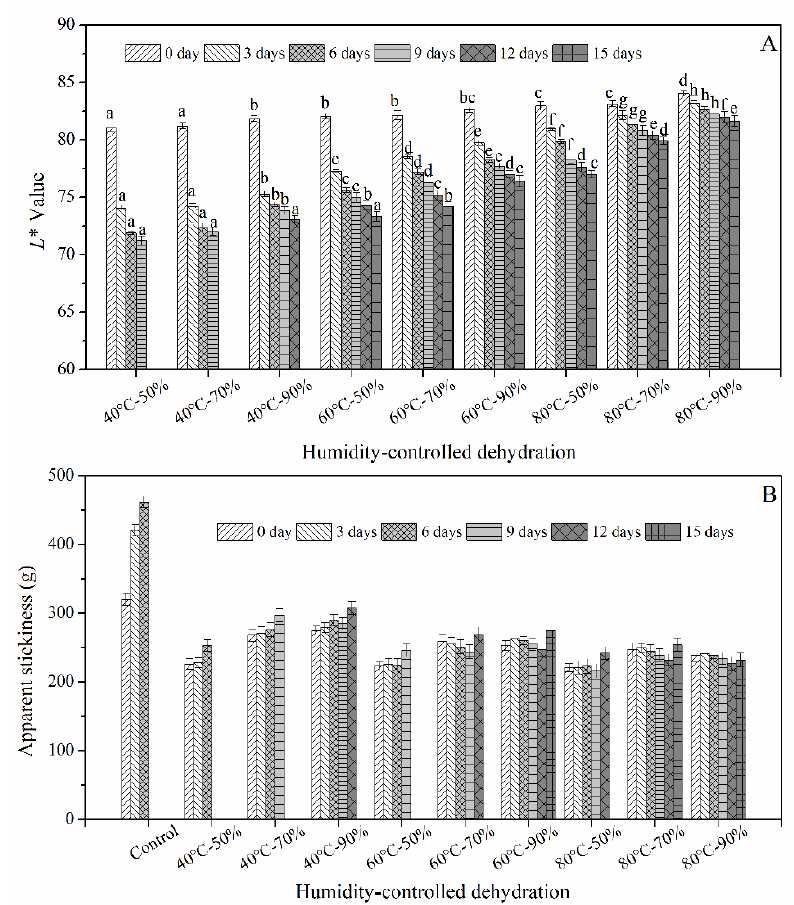
Figure 2. Effect of humidity-controlled dehydration on the L * value ( A ) and apparent stickiness ( B ) of fresh wet noodles during storage. Control, fresh wet noodles; 40 ◦ C-50%, fresh wet noodle samples treated by humidity-controlled dehydration under the condition of 40 ◦ C and RH of 50%, etc. The different lowercase letter means there was a significant difference in the same storage time ( p < 0.05).